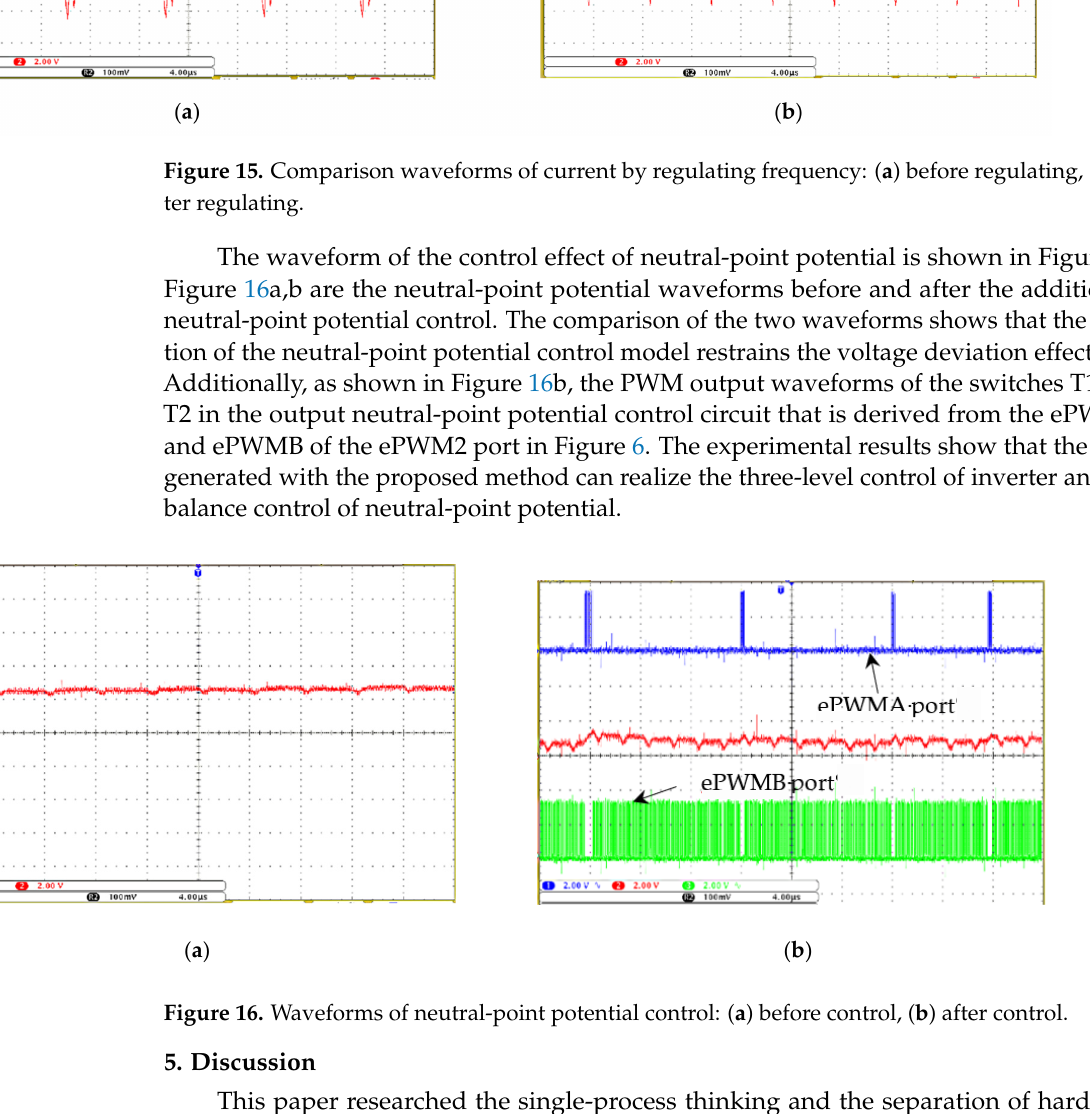
Table 1. Comparisons of harmonic current under different control.